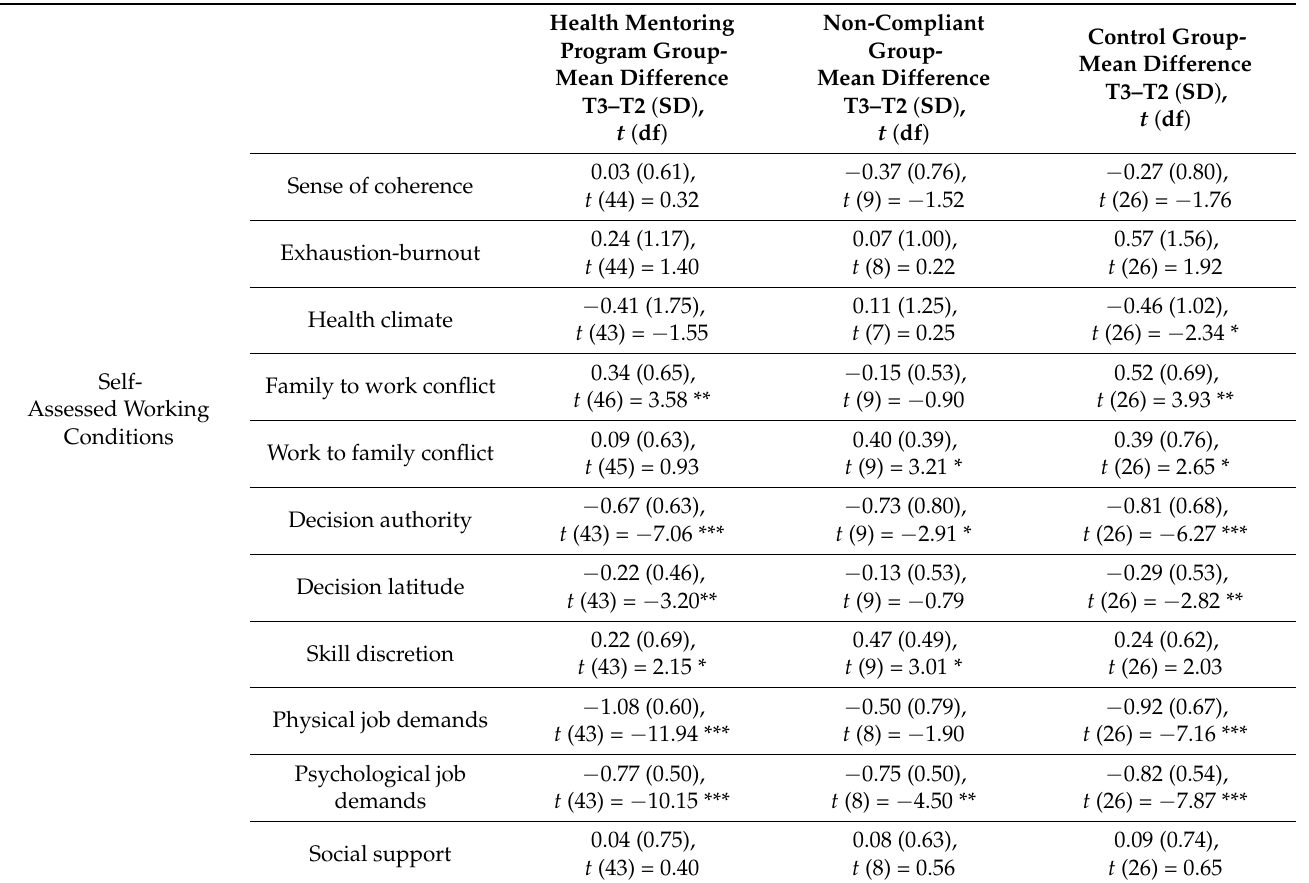
Table 5. Changes in self-assessed working conditions means from T2 to T3 within each study